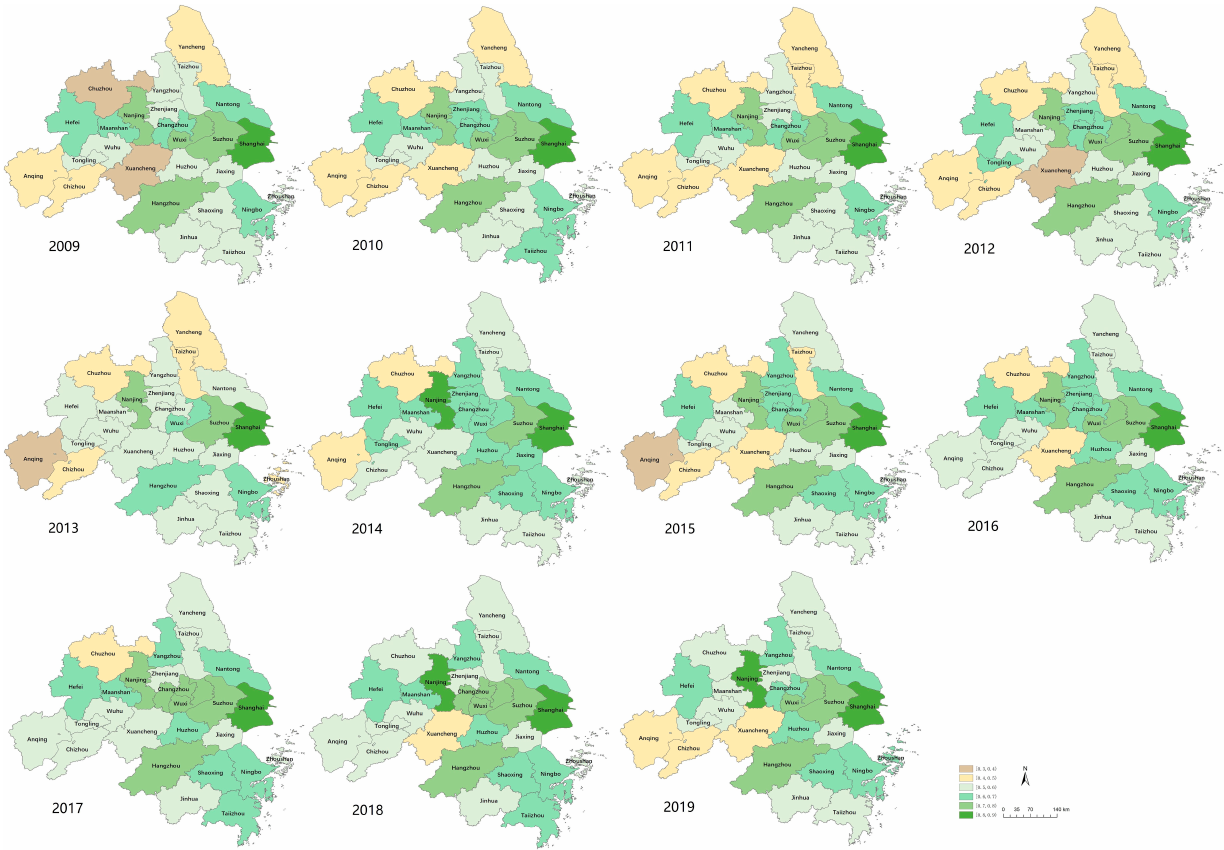
Figure 2. Spatial Distribution of ED and EE Coordination in YUA from 2009 to 2019.